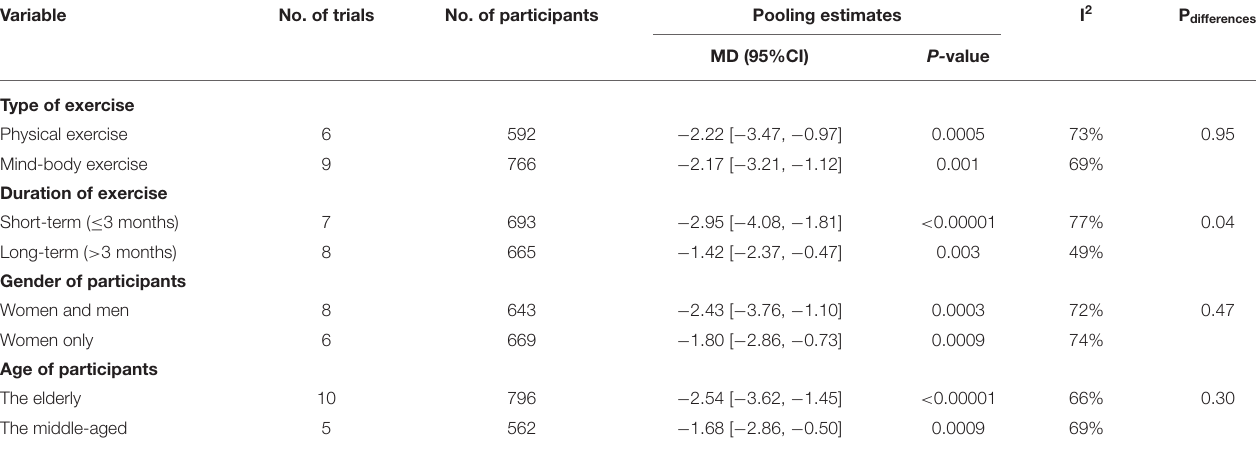
TABLE 2 | Subgroup analysis bases on exercise type, exercise duration, participants’ sex, participants’